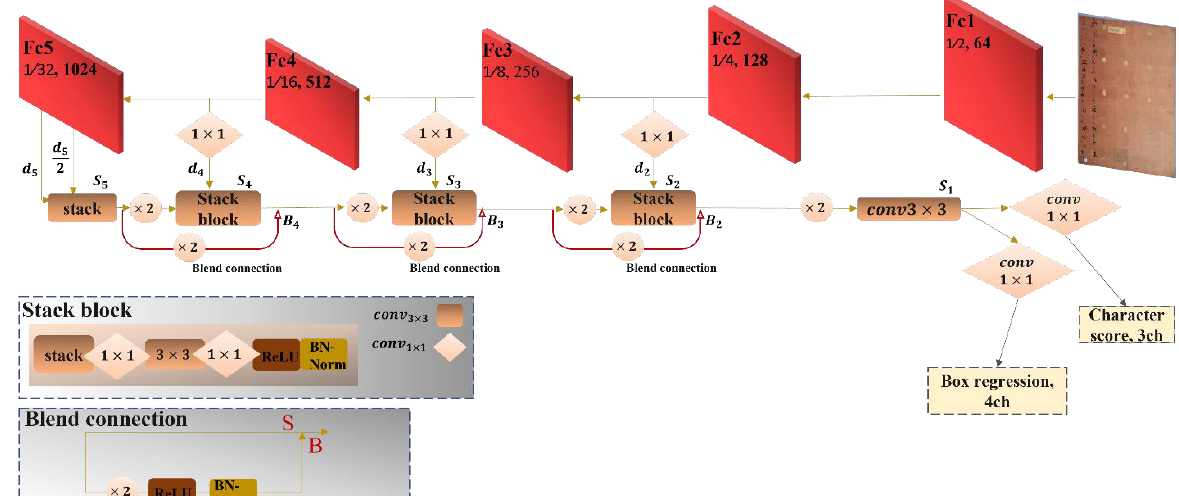
Figure 1. Overall design of the proposed FC-MSCCD. It has two parts: feature extraction and detection head. Feature extraction embraces two branches: trunk and stack branches with blend connections, which is residual-style learning. The detection head mainly consists of multi-channels for center prediction and bounding box regression after merely adding a 3 × 3 𝐶𝑜𝑛𝑣 layer followed by a 1 × 1 𝐶𝑜𝑛𝑣 layer. The schematics in the lower-left corner explain the stack block components and the flow of the blend connection.